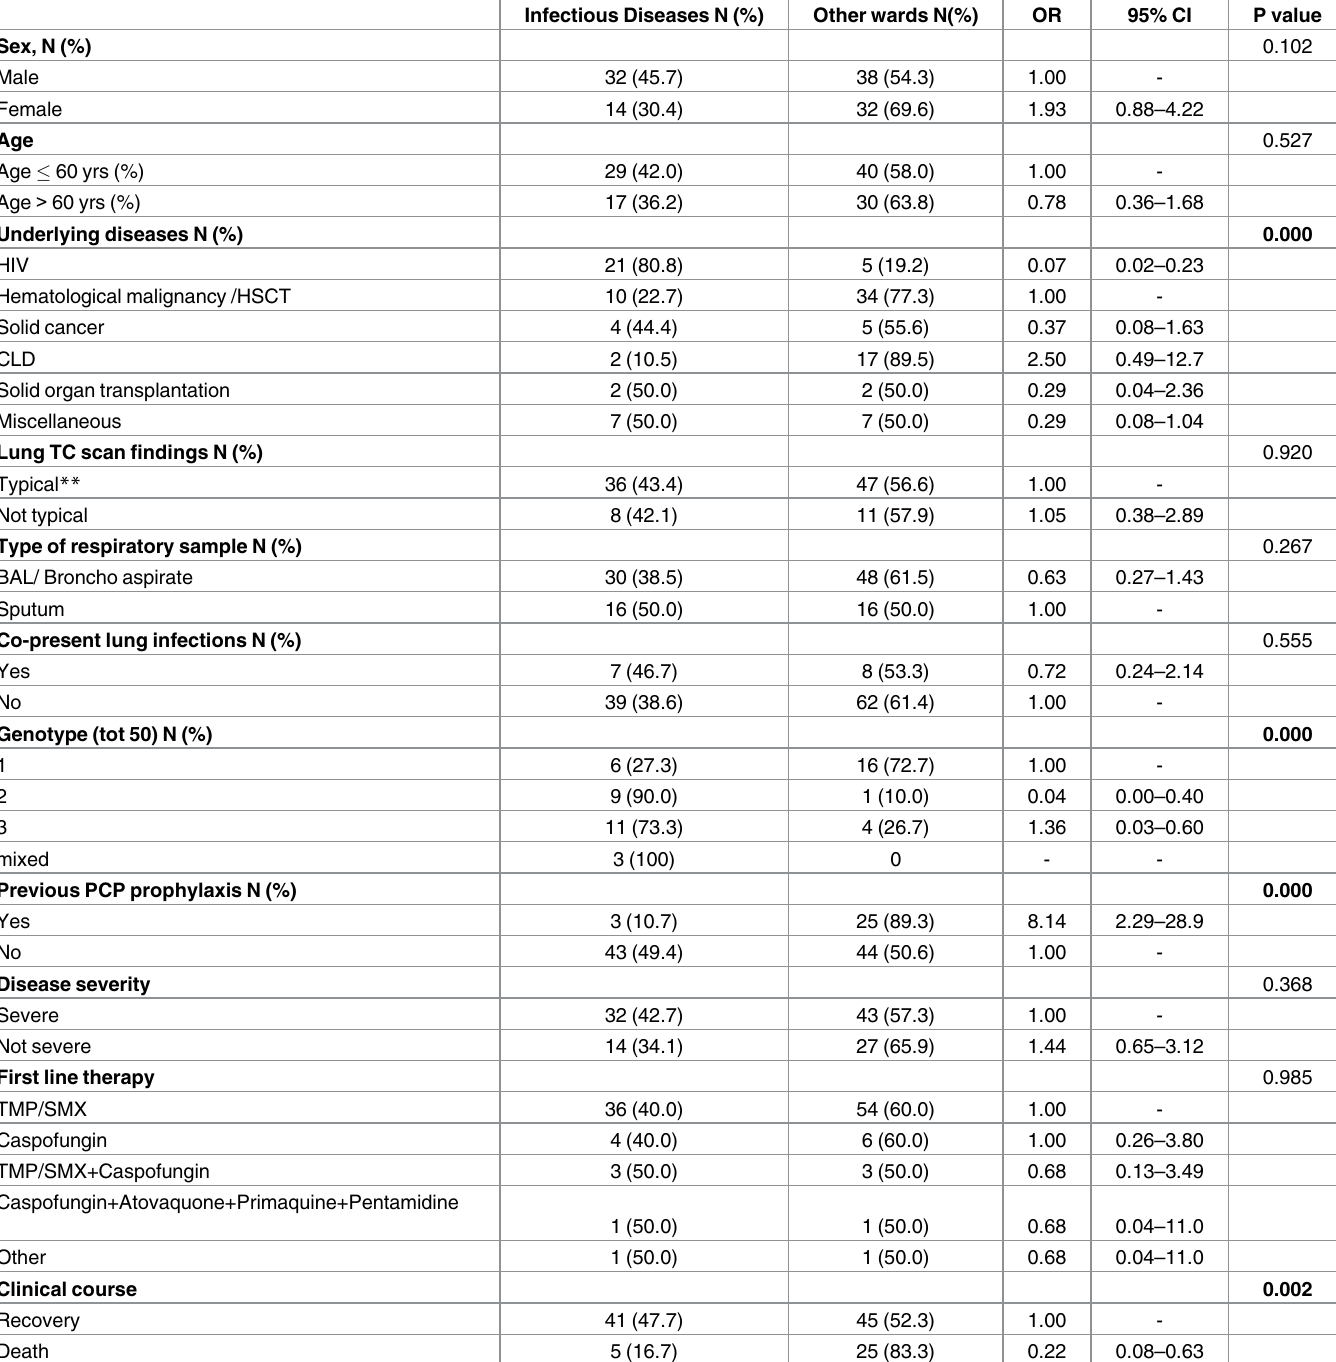
Table 3. General characteristics of patients with PjP admitted to Infectious Diseasesward versus those admitted on other